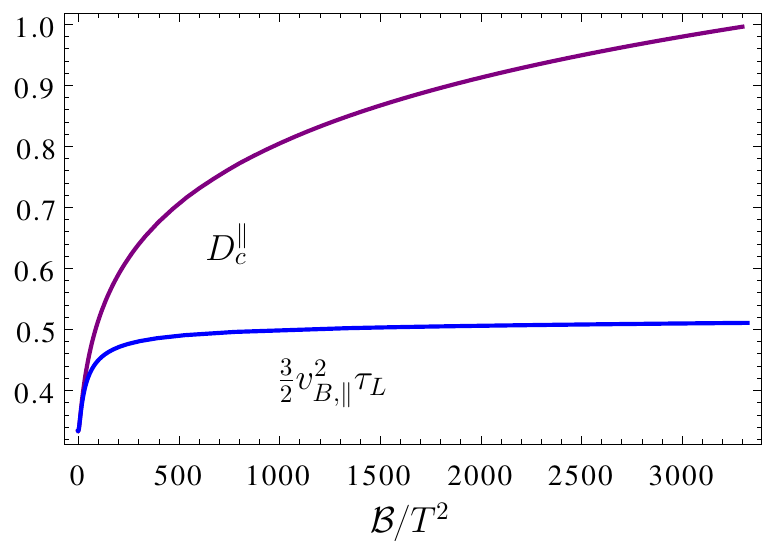
Figure 12 . Electric di(cid:11)usivity D k c (purple top curve) and 3 dimensionless parameter